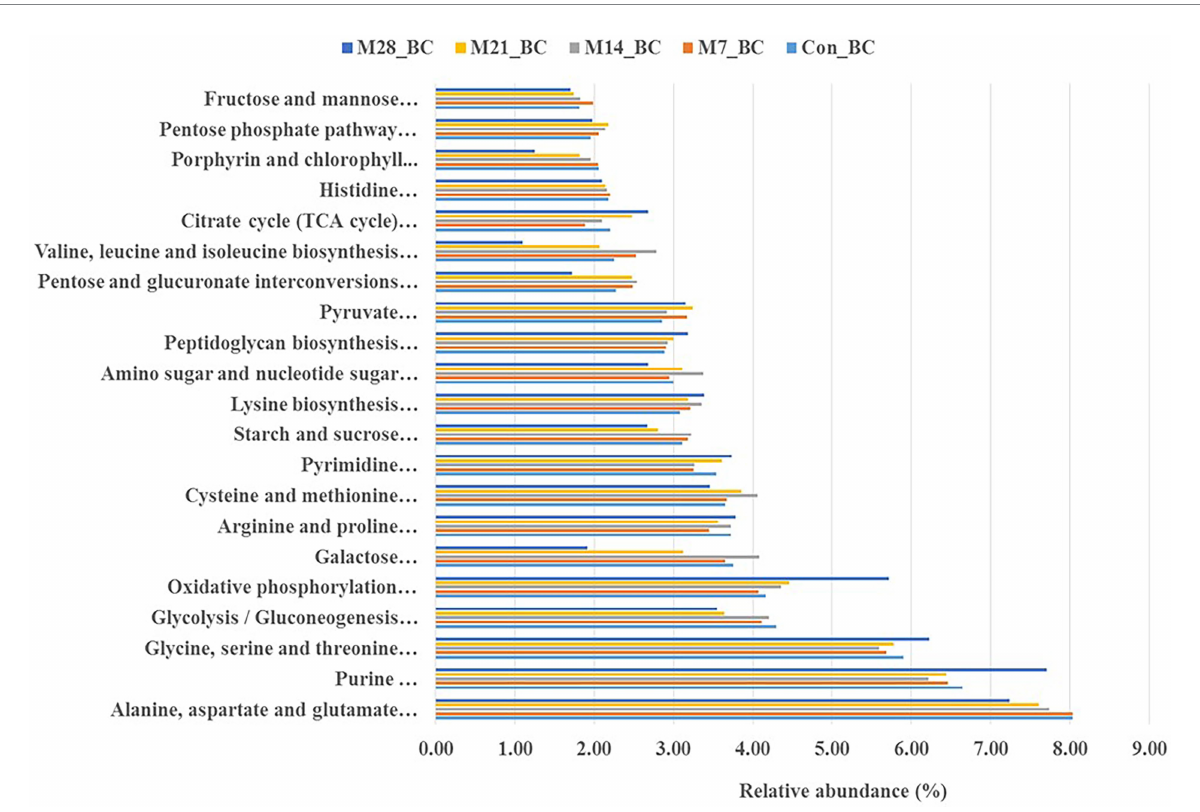
FIGURE 4 Bar plot showing relative abundance (mean > 1.02%) of the major functions (at level 1) of the microbial communities in caecum digesta samples from broiler chickens fed with diets containing different levels of marama bean meal [Treatment groups: 0% (Con_BC); 7% (M7_BC); 14%